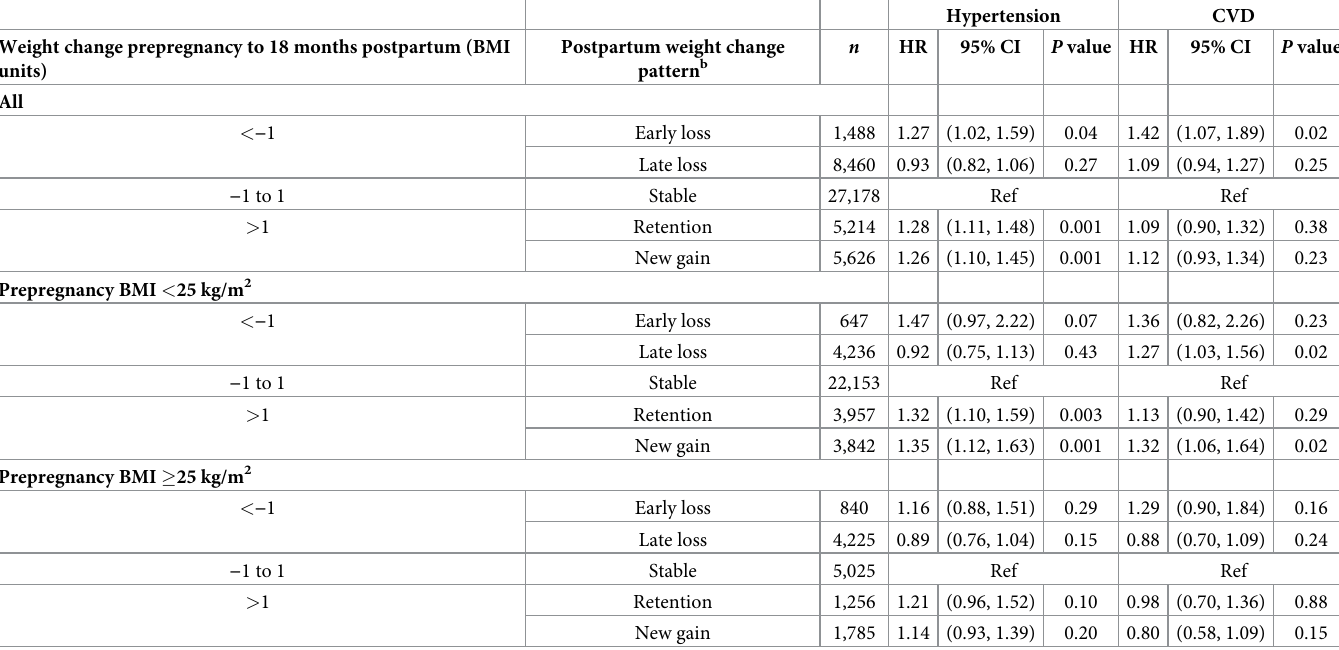
Table 4. Adjusted HRs a (95% CI) of hypertension and CVD according to weight change patterns from prepregnancy to18 months postpartum ( n =